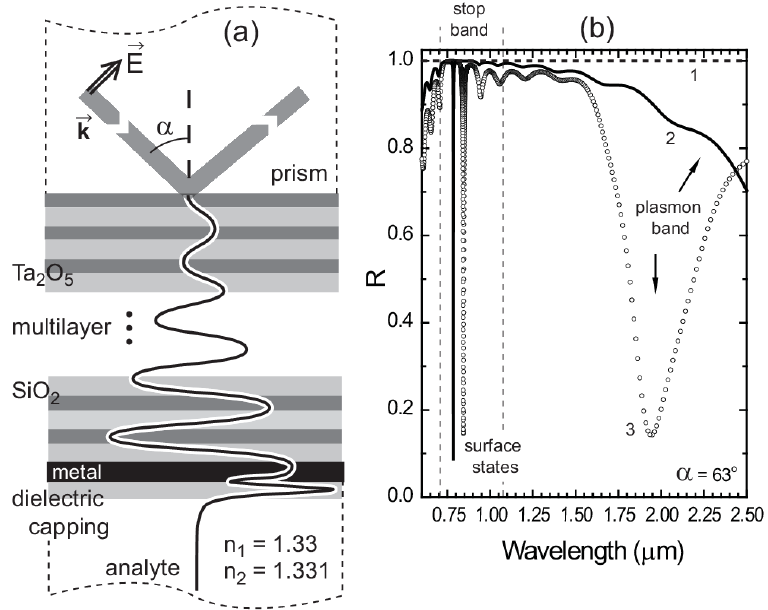
Figure 1. ( a ) Geometry of analysis with a schematic distribution of the E-field for a resonant wave inside a PPhC slab; ( b ) curves 1–3 show p-polarized reflection spectra of (Ta 2 O 5 /SiO 2 ) 10 PhC (dashed line), (Ta 2 O 5 /SiO 2 ) 10 /Au/SiO 2 PPhC slab comprising a 10-nm-thick Au layer (solid line) and a (Ta 2 O 5 /SiO 2 ) 10 /Au/SiO 2 PhC slab having a 40-nm-thick Au layer (circles). Spectra plotted in Figure 1b were calculated for the angle of incidence α = 63°.